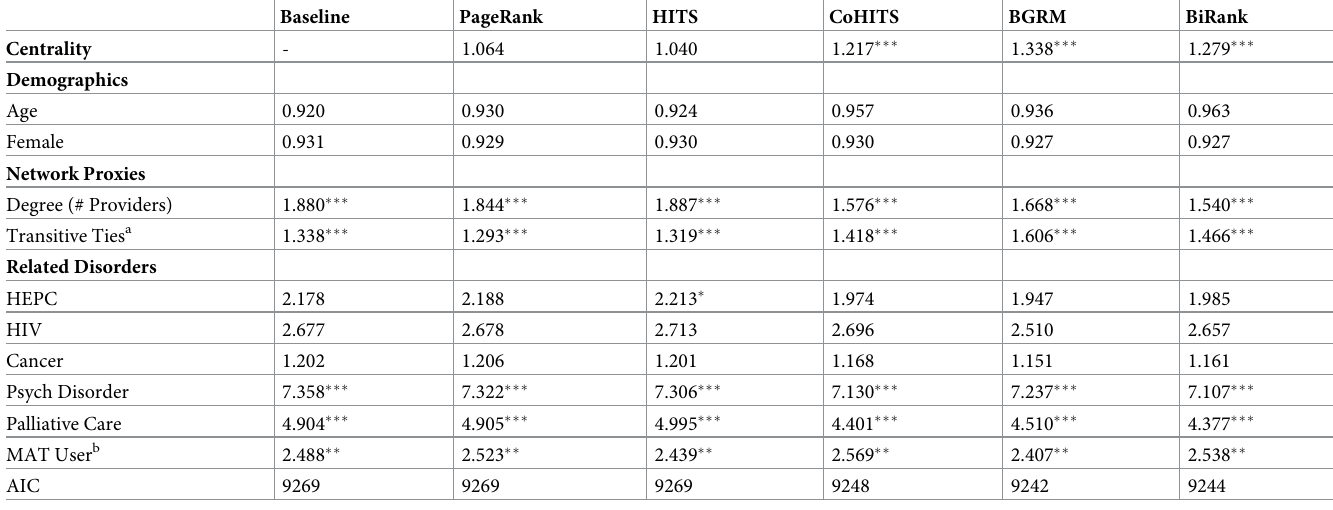
Table 2. Cox proportional hazard models for opioid